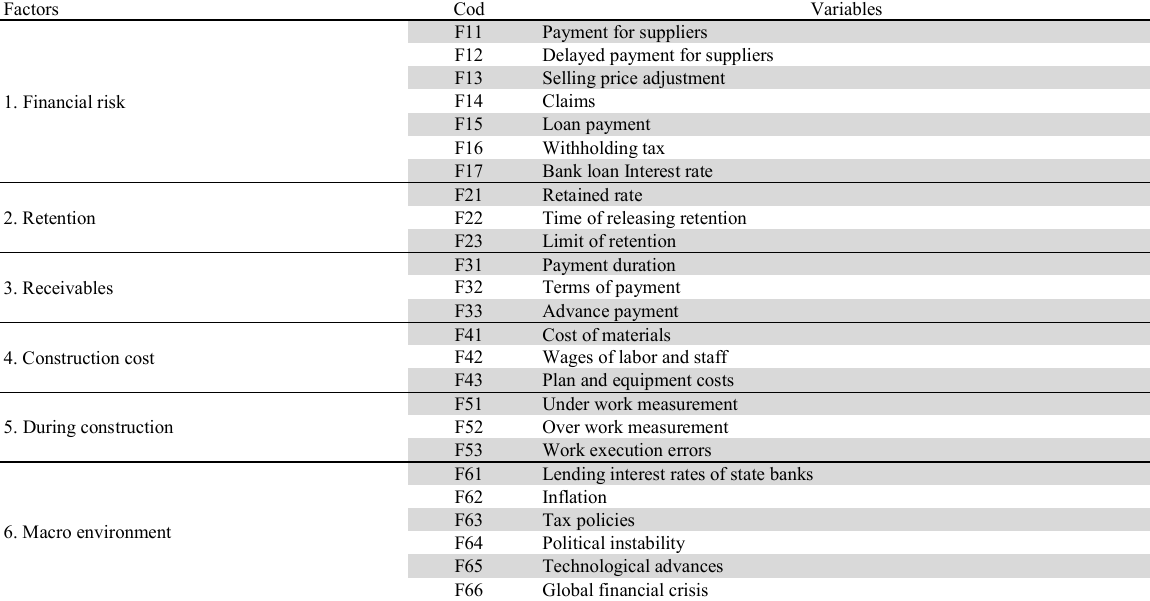
Detailed description of the scale